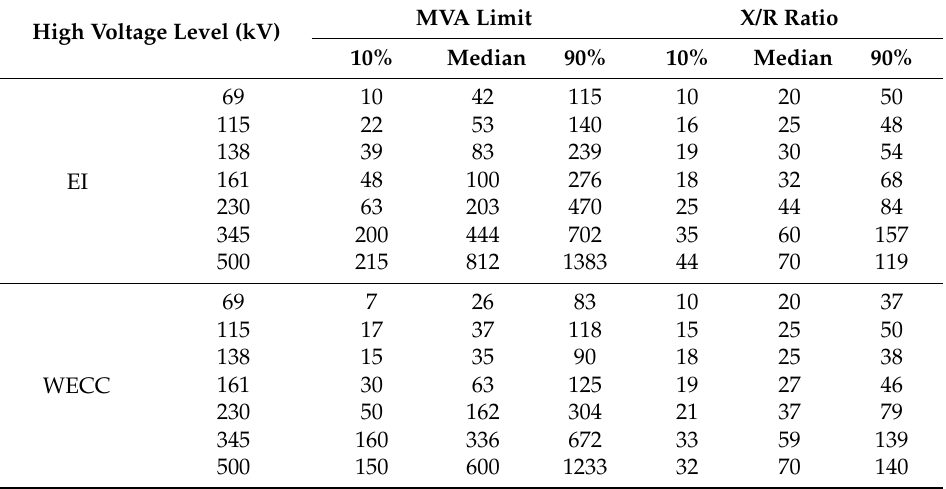
Table 2. Transformer Power (MVA: (Mega-Volt-Ampere)) limit and X/R statistics. High Voltage Level (kV)